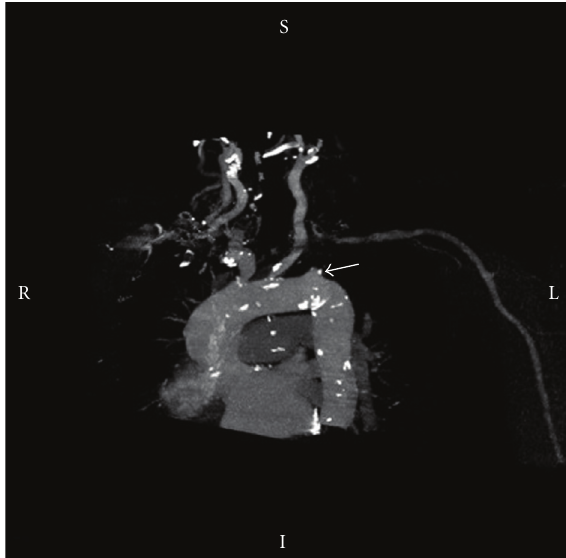
Figure 1: CT angiogram demonstrating the proximal stenosis of the left subclavian artery